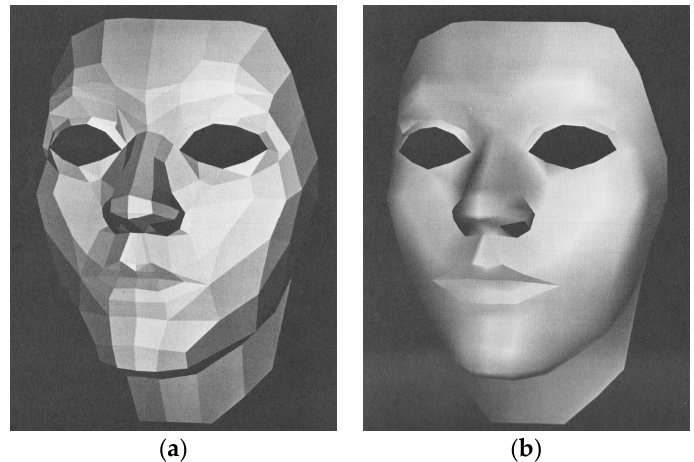
Figure 6. Henri Gouraud’s images of a human face: ( a ) A surfaces’ model; ( b ) The same one with smooth shaded